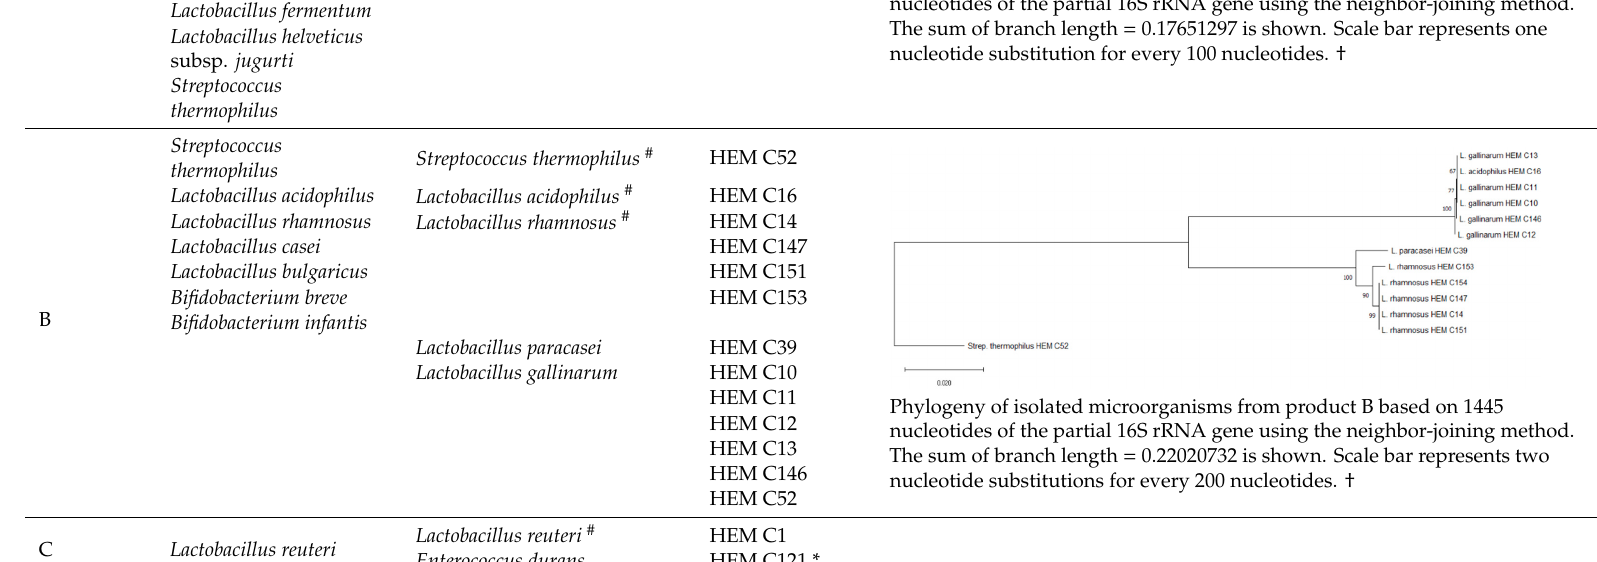
Phylogeny of isolated microorganisms from product A based on 1466 nucleotides of the partial 16S rRNA gene using the neighbor-joining method. The sum of branch length = 0.17651297 is shown. Scale bar represents one nucleotide substitution for every 100 nucleotides. †